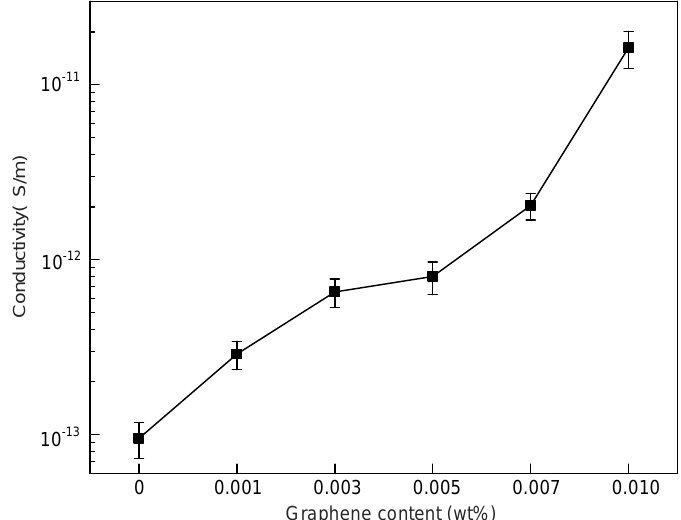
Figure 3. Conductivity of graphene/silicone rubber nanocomposites.